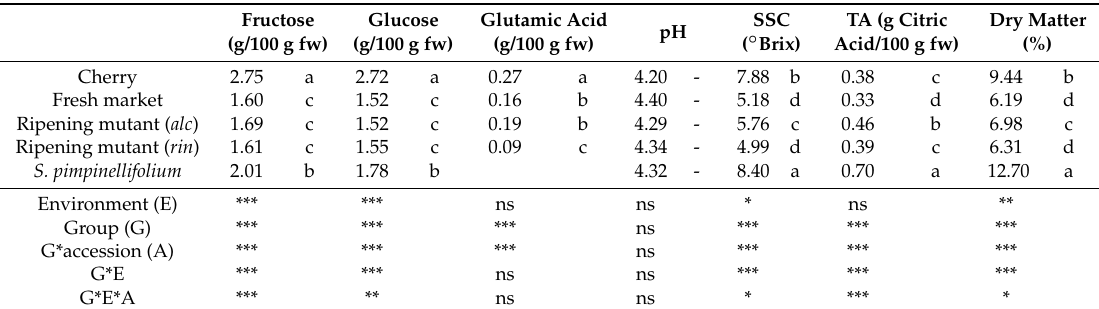
Table 2. Differences between tomato commercial groups for chemical traits. At the bottom, significance of the factors considered in the ANOVA (*** p < 0.001, ** p < 0.01, * p < 0.05, ns not significant). Within columns, different letters indicate significant differences (Student-Newman-Keuls test, at p < 0.05). SSC, soluble solids content; TA, titratable